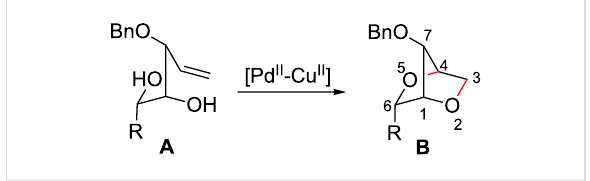
sugar-derived alkenitols A , that provided 2,5-dioxabi- cyclo[2.2.1]heptanes B with high 1,4- threo -selectivity (Scheme 1) [22,23]. In this process, the terminal carbon–carbon double bond is bis- O -functionalised with two hydroxy groups by sequential intramolecular–intramolecular reaction.